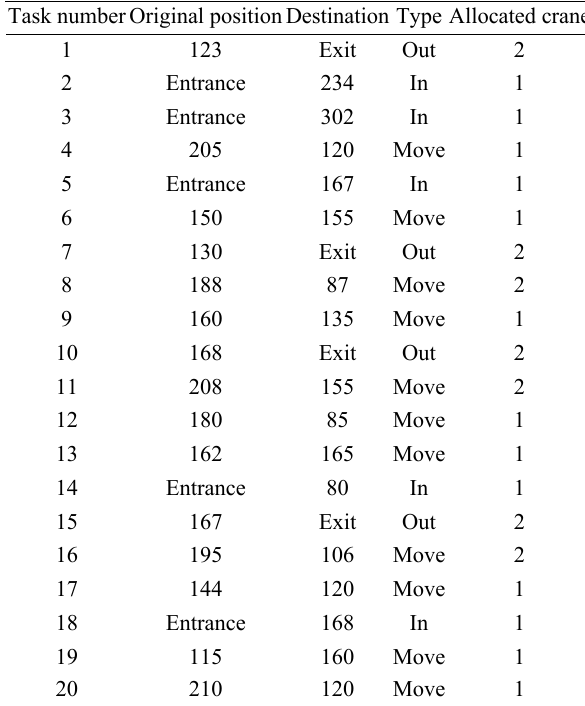
Table 2 Parameter table of different models. Model